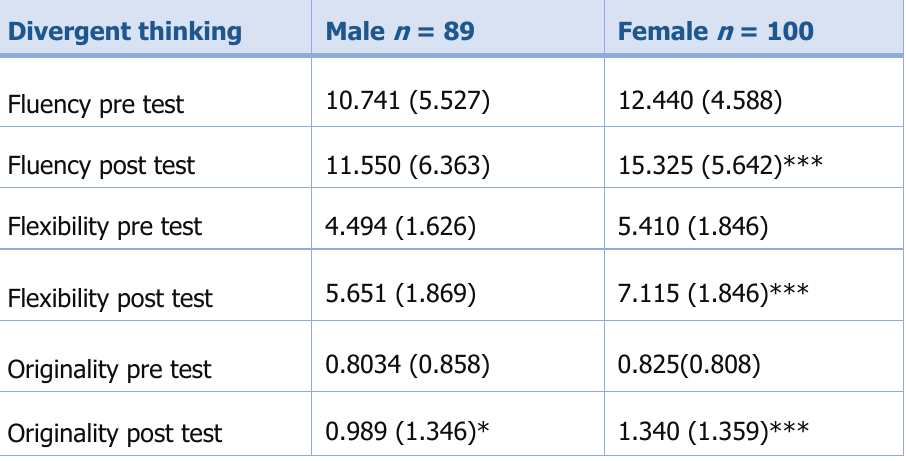
Table 3. Pre- and Post-Camp Differences in Divergent Thinking by Gender/Camps Divergent